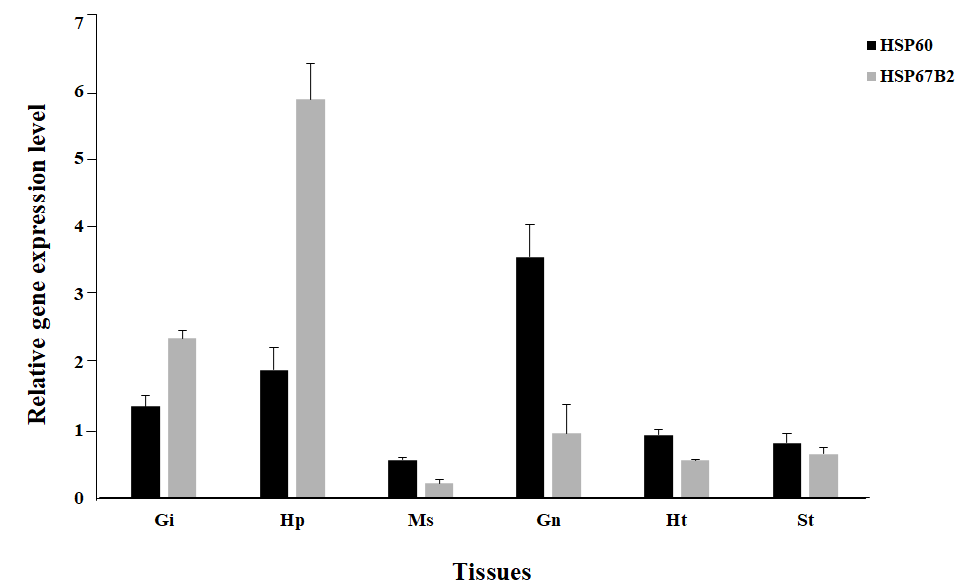
Figure 3. Relative mRNA expression levels of HSP60 and HSP67B2 in various Macrophthalmus japonicus tissues. Six tissues were used in this experiment. Quantitative reverse-transcription (RT)-PCR was conducted in triplicate. Bars indicate the standard deviation of the mean. mRNA expression was normalized against GAPDH . Abbreviations: Gill (Gi), Hepatopancreas (Hp), Muscle (Ms), Gonad (Gn), Heart (Ht), and Stomach (St).